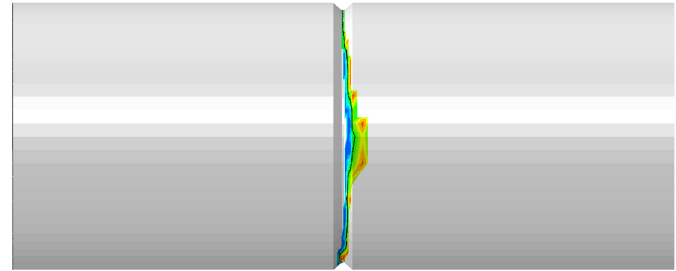
Figure 14. PHILSM cloud image of fatigue crack propagation.